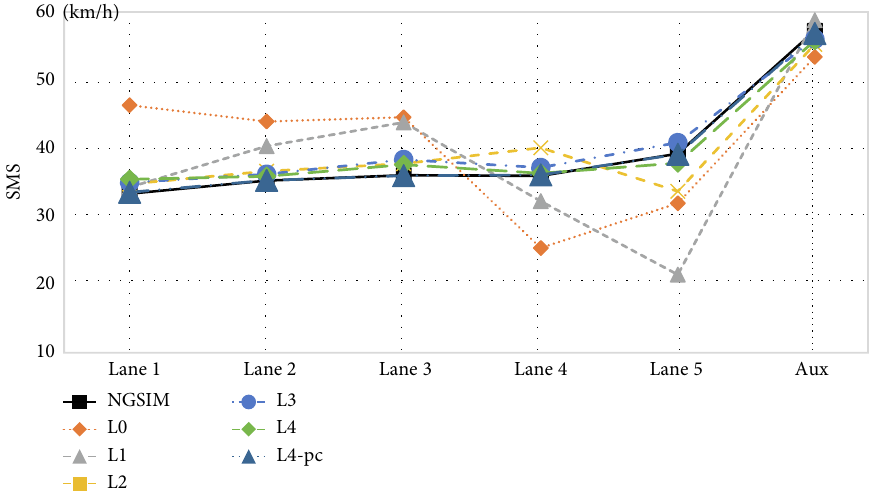
Figure 4: Comparison of SMS per lane for each calibration level.